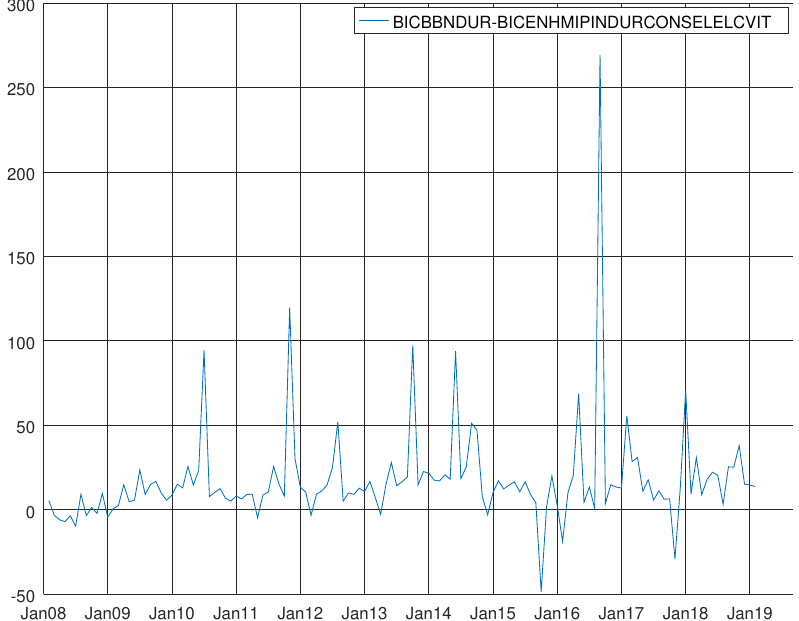
Figure 22. Graph shows the p -values of the Harvey heteroskedasticity test for the barebone model for durable goods. The null hypothesis states that the residuals are not heteroskedastic.